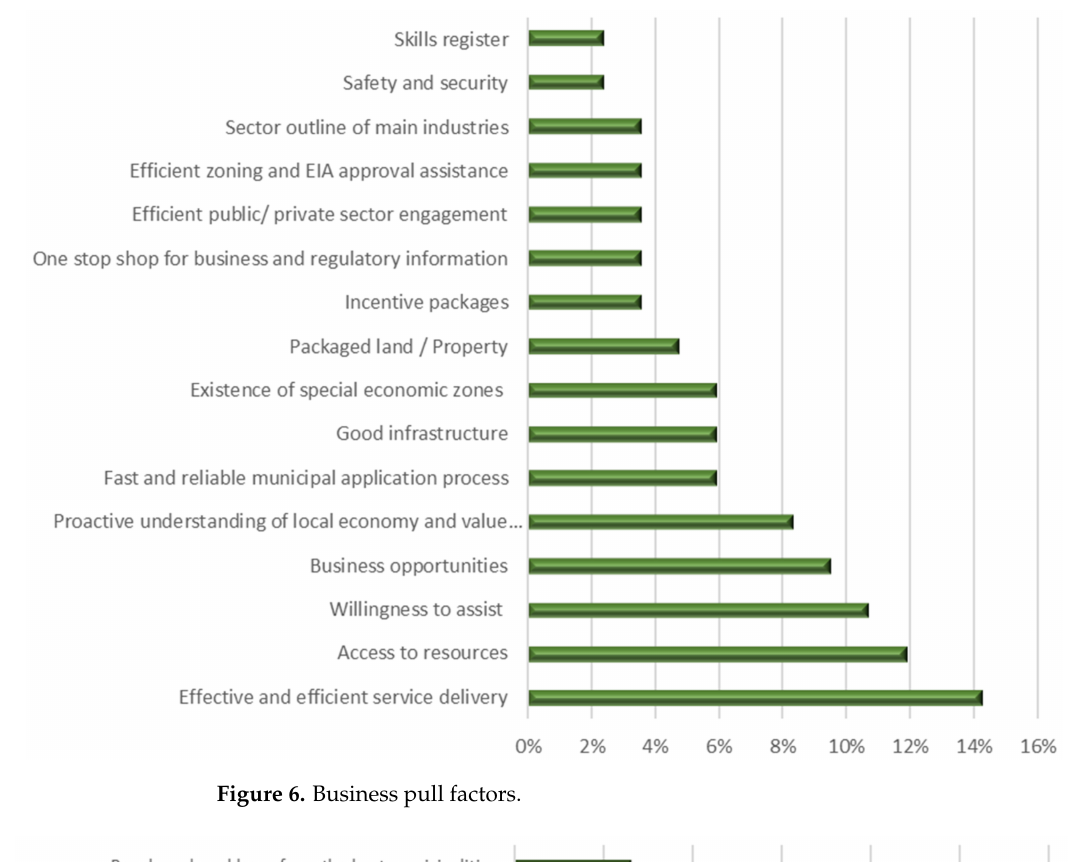
Figure 6. Business pull factors.